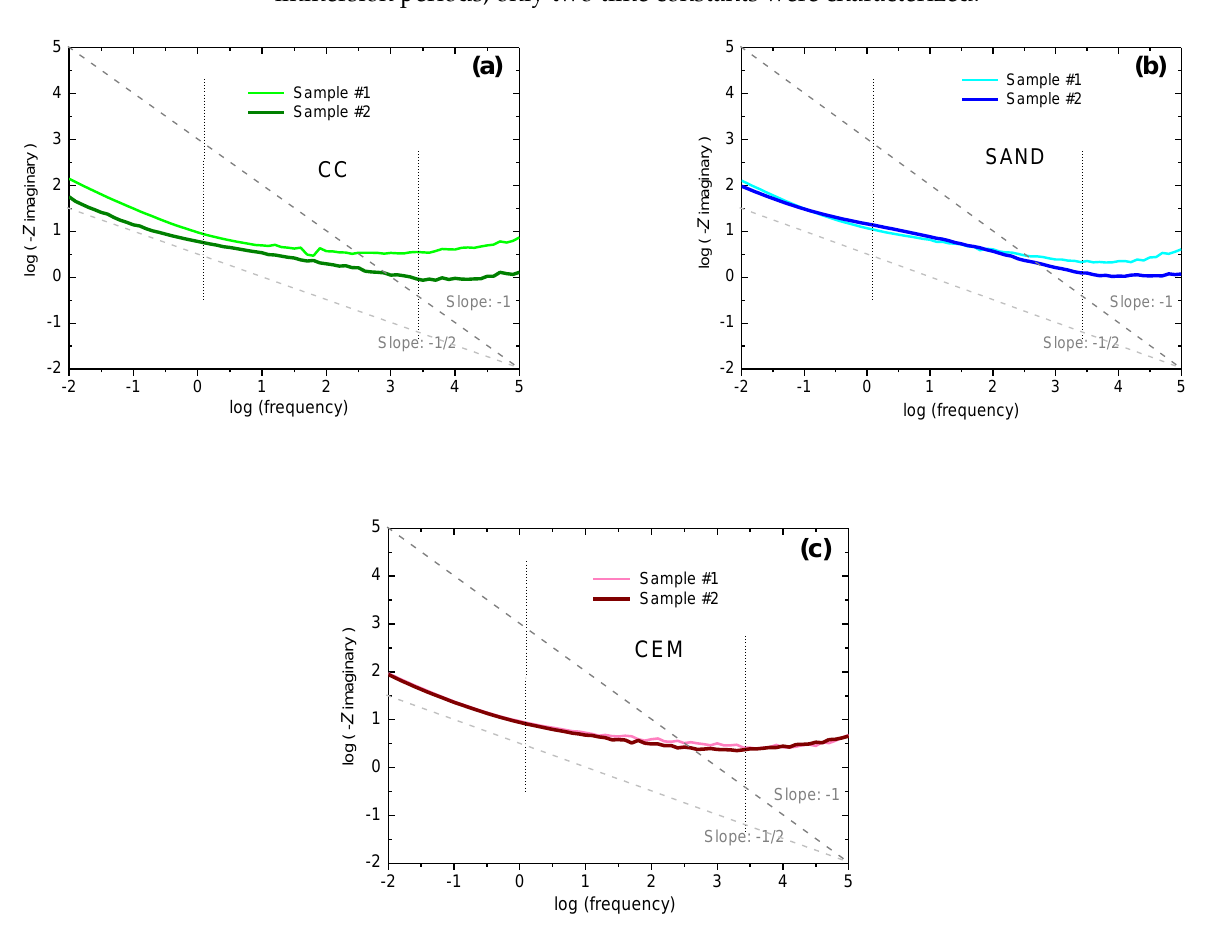
Figure 6. Moduli of the imaginary parts of the impedances vs. frequencies of: ( a ) the CC, ( b ) the SAND and ( c ) the CEM samples (Figure 6a–c, respectively) samples over 7 days of immersion in NaCl solution. Porous behavior is characterized when slopes are about − 1/2 or lower ( − 1/4), while the planar electrode behavior has a slope of about − 1.